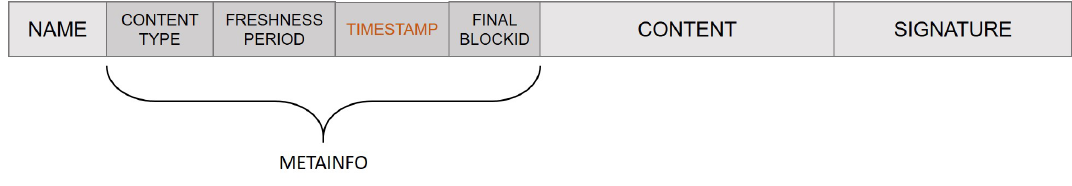
Figure 3. New structure of the NDN Data